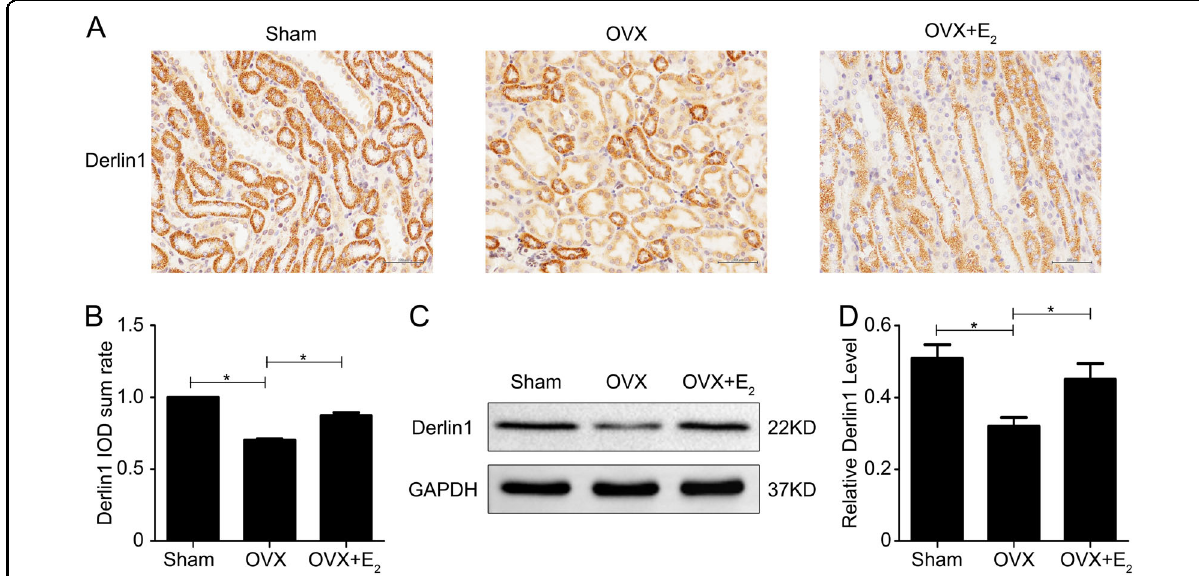
Fig. 4 Estrogen de fi ciency decreases the expression of derlin-1 in the kidneys of rats. a The expression of derlin-1 in rat kidneys was examined by immunohistochemical staining. b Quanti fi cation of the positive staining for derlin-1 protein in ( a ). c Western blot analysis was performed to examine derlin-1 expression in kidney lysates from the different treatment groups. d Quantitation of the western blot data for derlin-1 expression shown in c normalized to GAPDH expression. The bars are the means ± SE values from three independent experiments. *P < 0.05